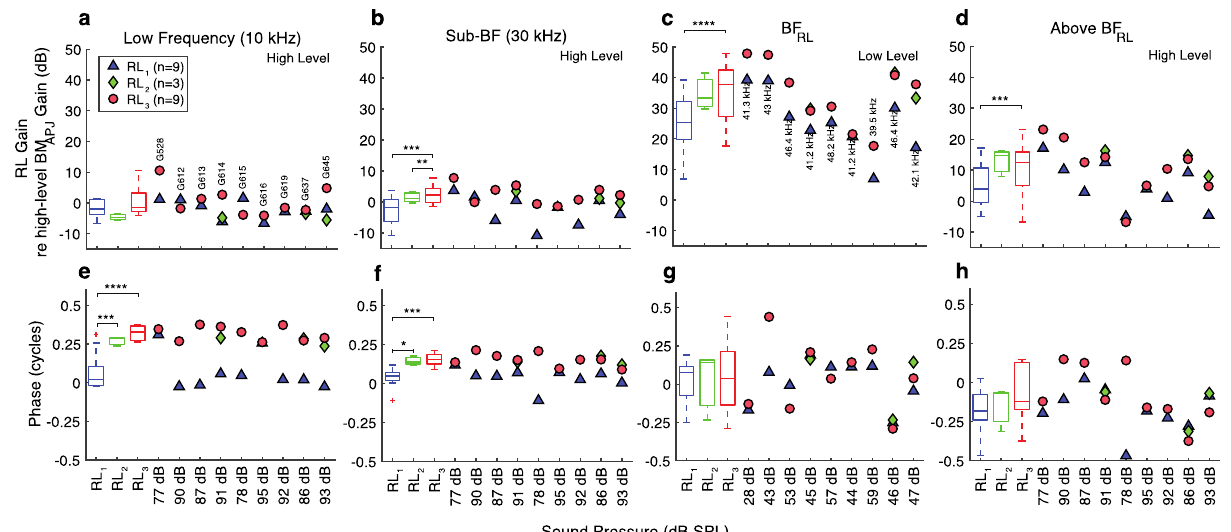
Figure 5. Summary comparisons across animals of the in vivo normalized gains at the apical ends of the OHC rows (RL 3, 2, 1 ), for selected frequencies. ( a–d ) The respective normalized-gain magnitudes at a low frequency (10 kHz, high stimulus level), near 30 kHz (Sub-BF, high stimulus level), at BF RL (low stimulus level), and above BF (high stimulus level). The above-BF RL frequencies used in panels ( d ) and ( h ) correspond to the high- stimulus-level magnitude peak for each animal. ( e–h ) The phase summaries corresponding to panels ( a–d ), respectively. The individual datapoints in columns 1–2 were averaged over a 1/3-octave width centered around 10 and 30 kHz, respectively, while those in column 4 were averaged over a 1/6-octave width centered around the selected frequency. The points shown in column 3 each represent the value at a single frequency. Note that the stimulus levels listed on the horizontal axes and BF values labeled in panel c vary across animals (labeled in panel a ). The box-and-whisker plots on the left-hand side of each panel provide statistical summaries of the individual results, matched by color. The ANOVA p -values between categories are indicated by horizontal brackets at the top. The number of asterisks above each bracket corresponds to the following degrees of statistical significance: p < 0.05 (*), p < 0.02 (**), p < 0.006 (***), and p < 0.001 (****), all of which are of greater significance than the p 0 = 0.05 criterion. Insignificant p -values are not displayed. The red ‘ + ’ symbols indicate outliers, the boxes indicate the interquartile range (IQR) with 95% confidence, and the horizontal line inside each box indicates the median value. The whiskers indicate the minimum and maximum of the range (excluding outliers). In some cases the RL 2 whiskers are too small to be visible. The RL 3, 2, 1 results for animal G637 are shown in Figs. 3 and